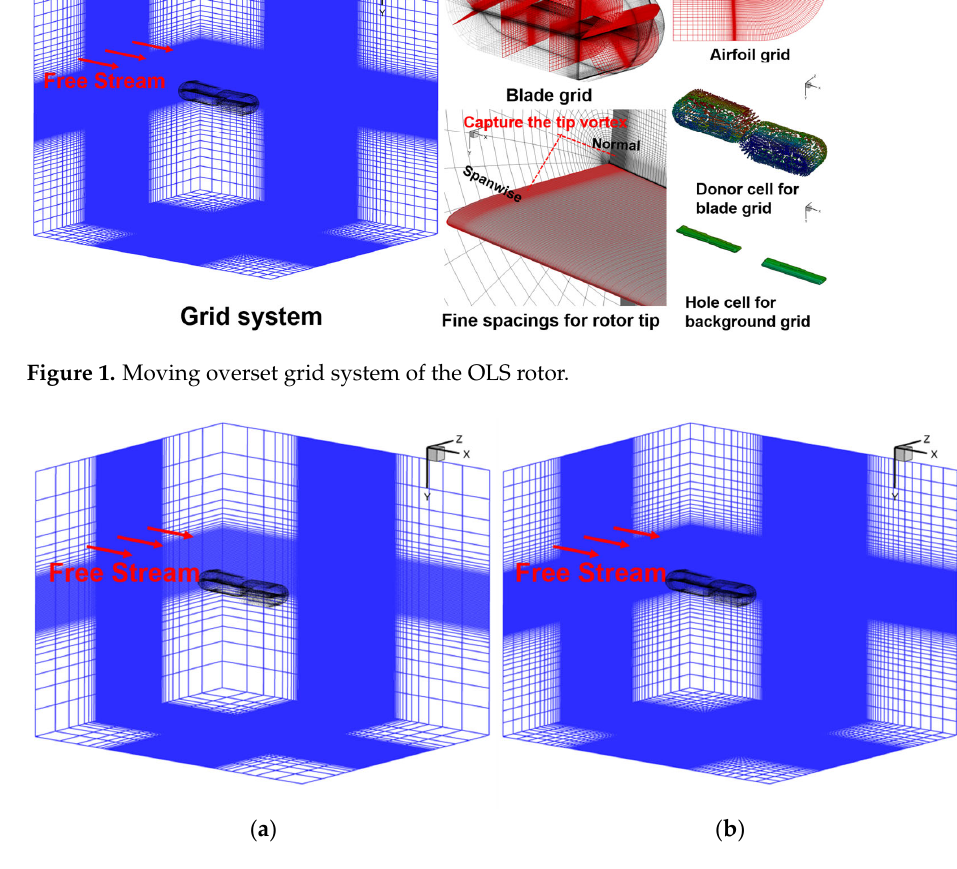
Figure 2. Coarse and fine background grids of the OLS rotor: ( a ) Coarse grid case; ( b ) fine grid case .